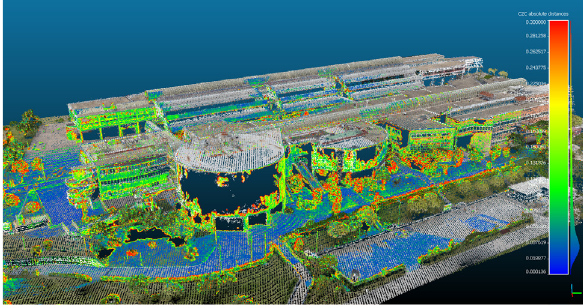
Figure 17. UAV/TIMMS main front view cloud deviation